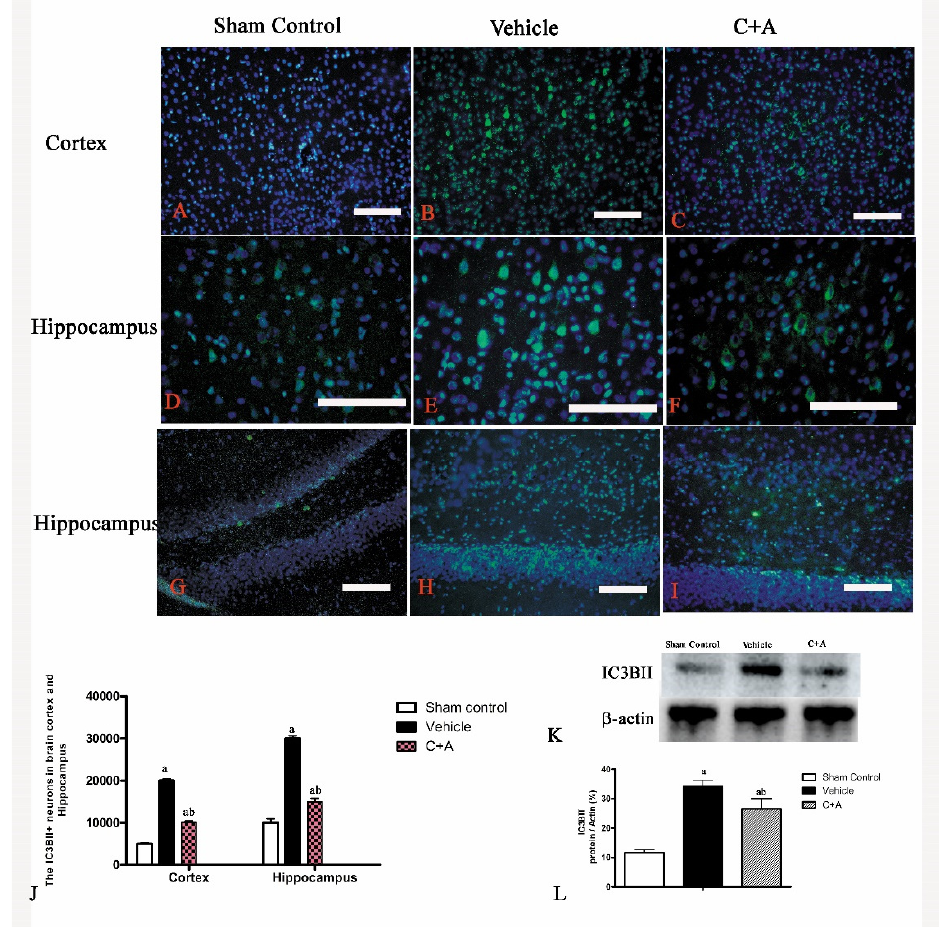
Figure 6. ( A – I ): Immunofluorescence staining (green) of LC3BII in the motor cortex and hippocampus. Scale bar = 100 µm. ( J ) The quantification of LC3BII-positive cells showed that treatment with C16 plus Ang-1 reduced the number of LC3BII-positive cells compared to the vehicle controls. ( K ) Western blot analysis of the expressions of autophagy marker LC3BII. ( L ) Semi-quantitative profiles of protein bands showed that C16 plus Ang-1 suppressed the upregulation of LC3BII in the vehicle group. LC3BII, 14.16 KD; β -actin, 42 KD. a, p < 0.05 vs. sham control group; b, p < 0.05 vs. vehicle group.